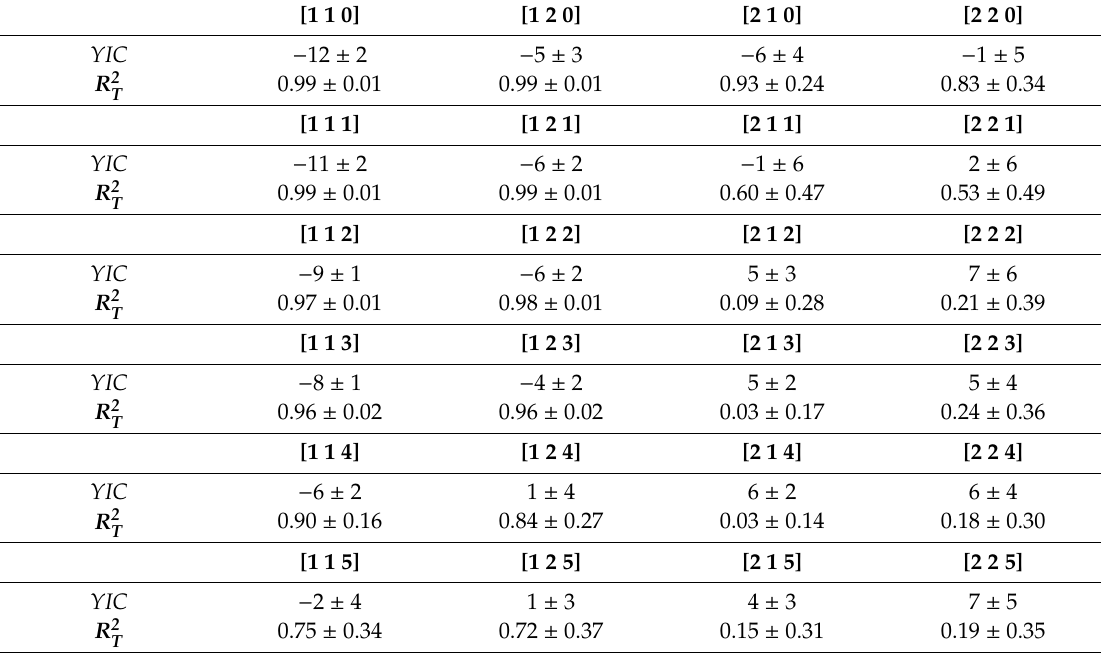
Table 1. Average Young information criterion ( YIC ) and coe ffi cient of determination, R 2 with their standard deviation, obtained during the system identification process for each of the 32 sub-datasets created from the Minnesota starvation excel spreadsheet used in the work of [31]. [ n a n b δ ] indicates the di ff erent combinations (24 in total) of time –invariant first and second order models: number of a -parameters ( n a ) ranging from 1 to 2 (Equation (2)), number of b -parameters ( n b ) ranging from 1 to 2 (Equation (3)) and delays ( δ ) ranging from 0 to 5 samples. [1 1 0] [1 2 0] YIC − 12 ± 2